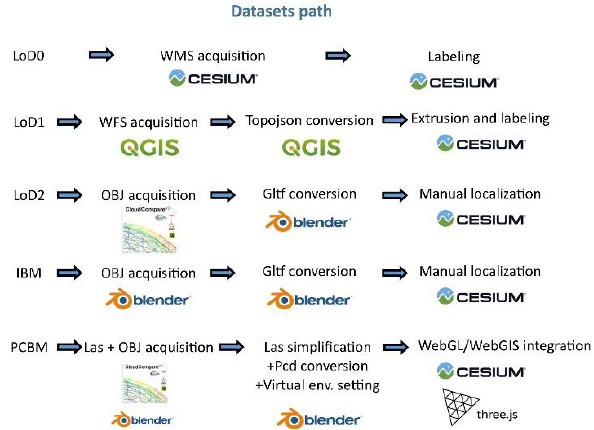
Figure 7 . The description of the different elaboration paths of the